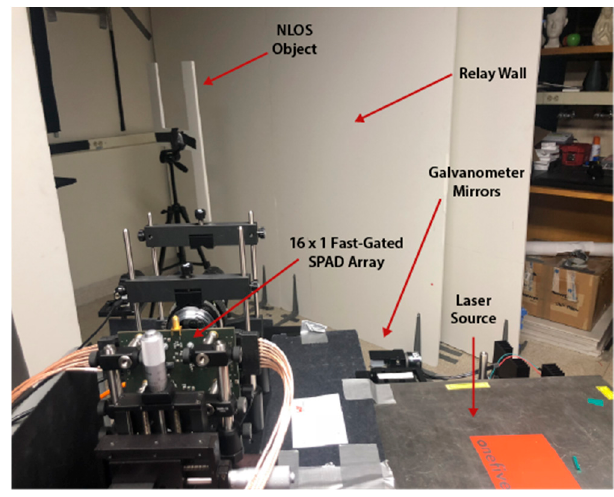
Figure 12. Picture of the Non-Line-Of-Sight (NLOS) measurement scene, including: the 16 × 1 fast-gated SPAD array, the laser source (behind the grey screen) and the galvo mirrors, the relay wall and finally the NLOS object (a number “4” made of white paper).